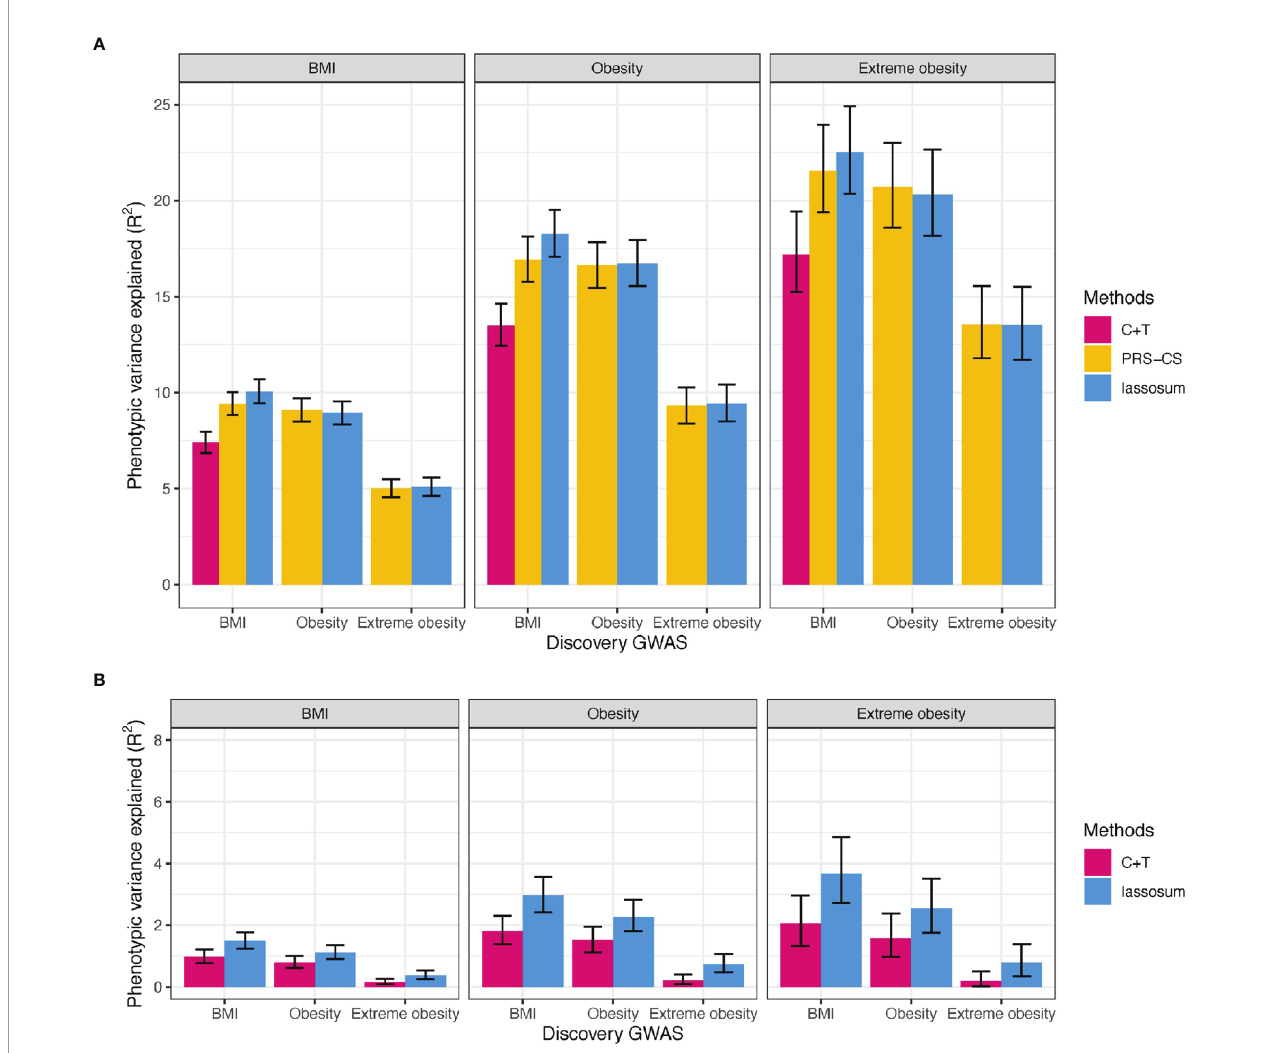
FIGURE 3 | Variance explained by PRS for BMI, obesity, and extreme obesity in BMI, obesity and extreme obesity. (A) PRScommon (B) PRSrare, We reported adjusted R 2 for BMI, Nagelkerke ’ s R 2 for (extreme) obesity on top of covariates including age, sex, study and PCs. C+T: Clumping and Thresholding method. Error bars indicates 95%